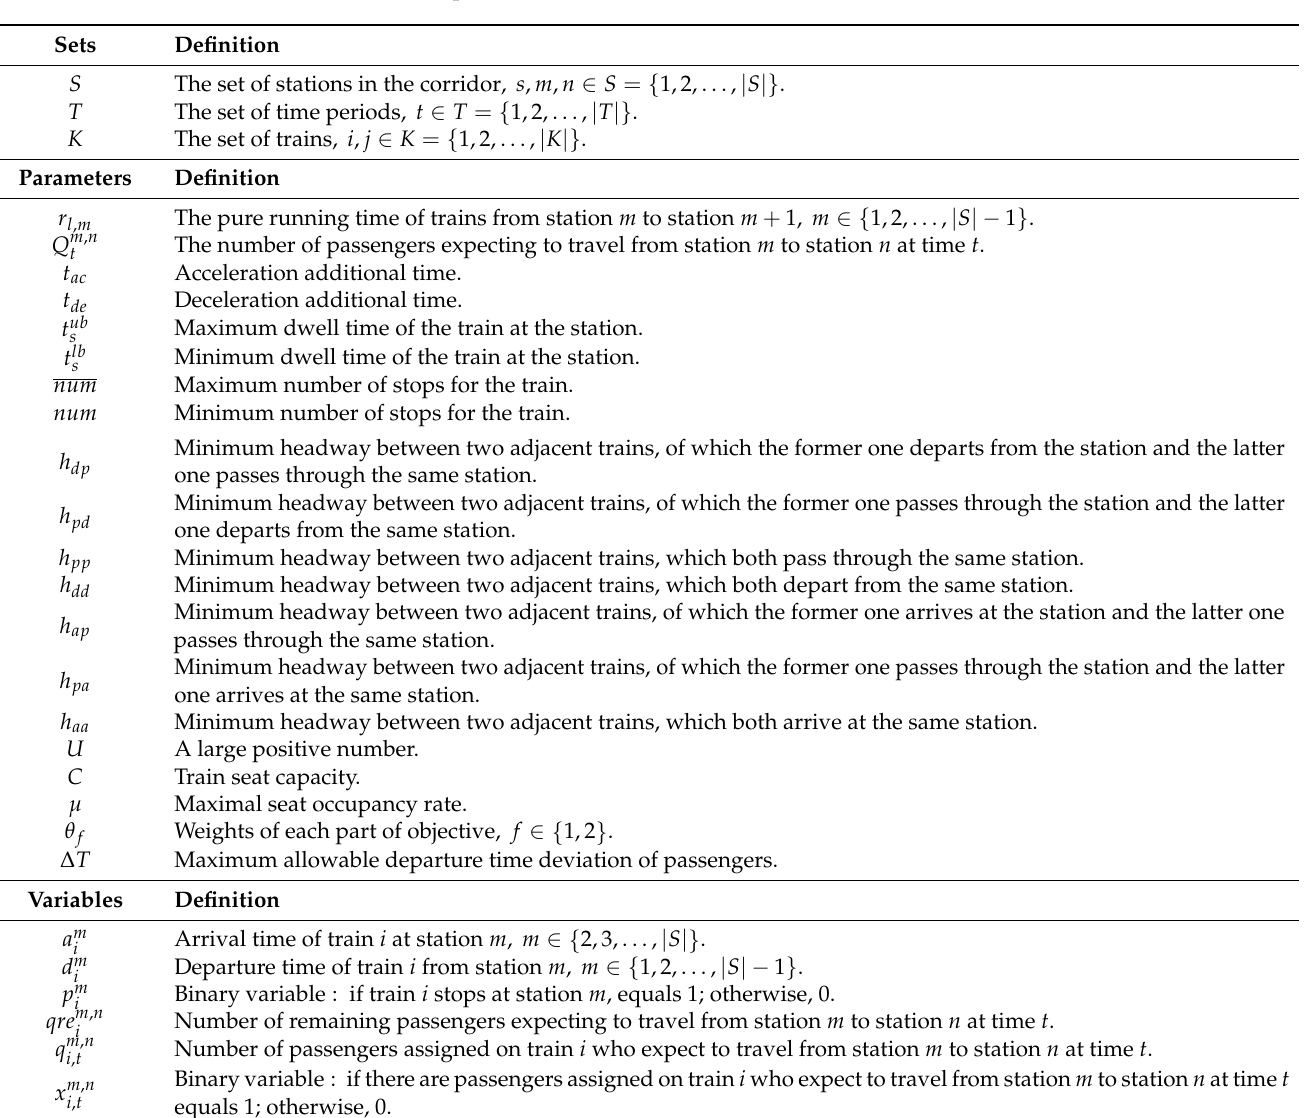
Table 5. Sets, parameters and variables used in the